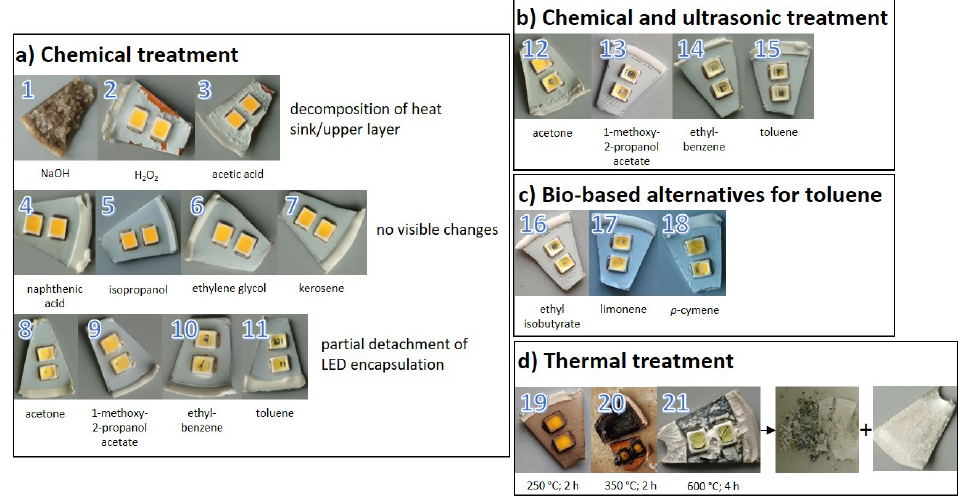
Figure 4. Liberation